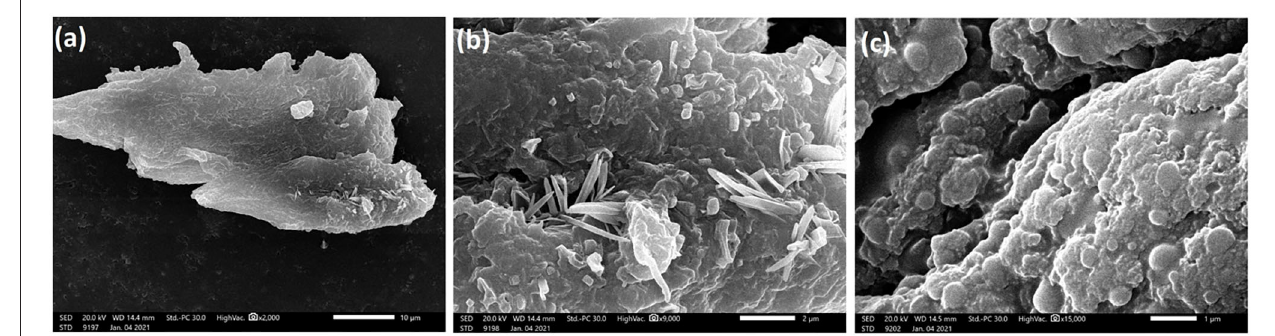
FIGURE 4 | SEM images of the produced exopolysaccharide (EI6-EPS) at 2,000 × (A) , 9,000 × (B) , and 15,000 × (C)